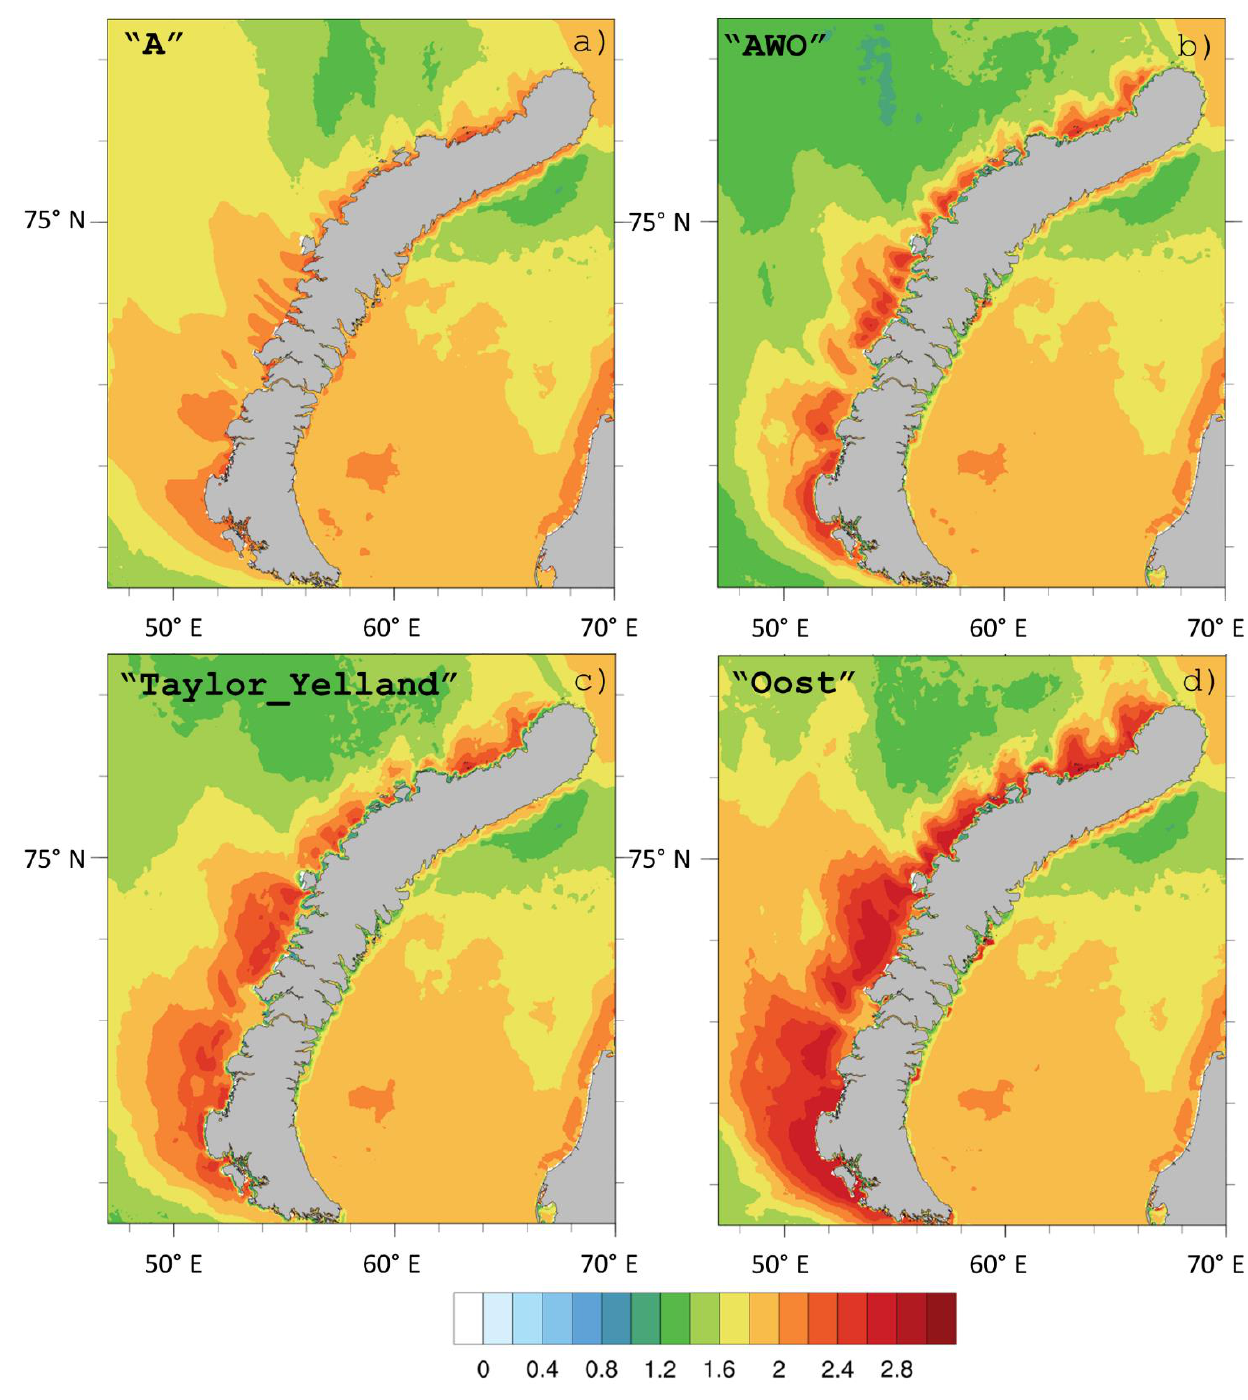
Figure 8. Drag coefficient (×10 3 ) in experiments “A” ( a ), “AWO” ( b ), “Taylor_Yelland” ( c ) and “Oost” ( d ), averaged over the bora period (December 10 – 12).